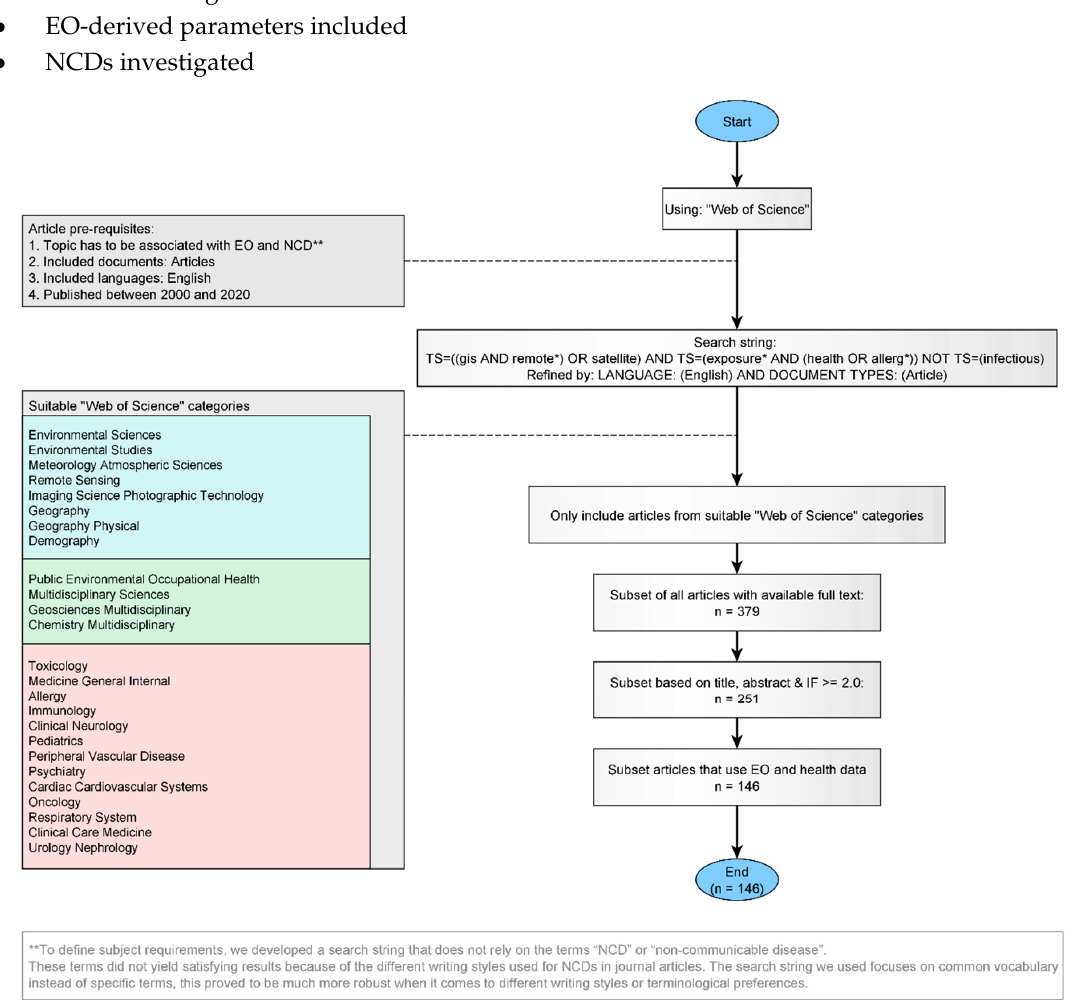
Figure 2. Selection process developed for this review.